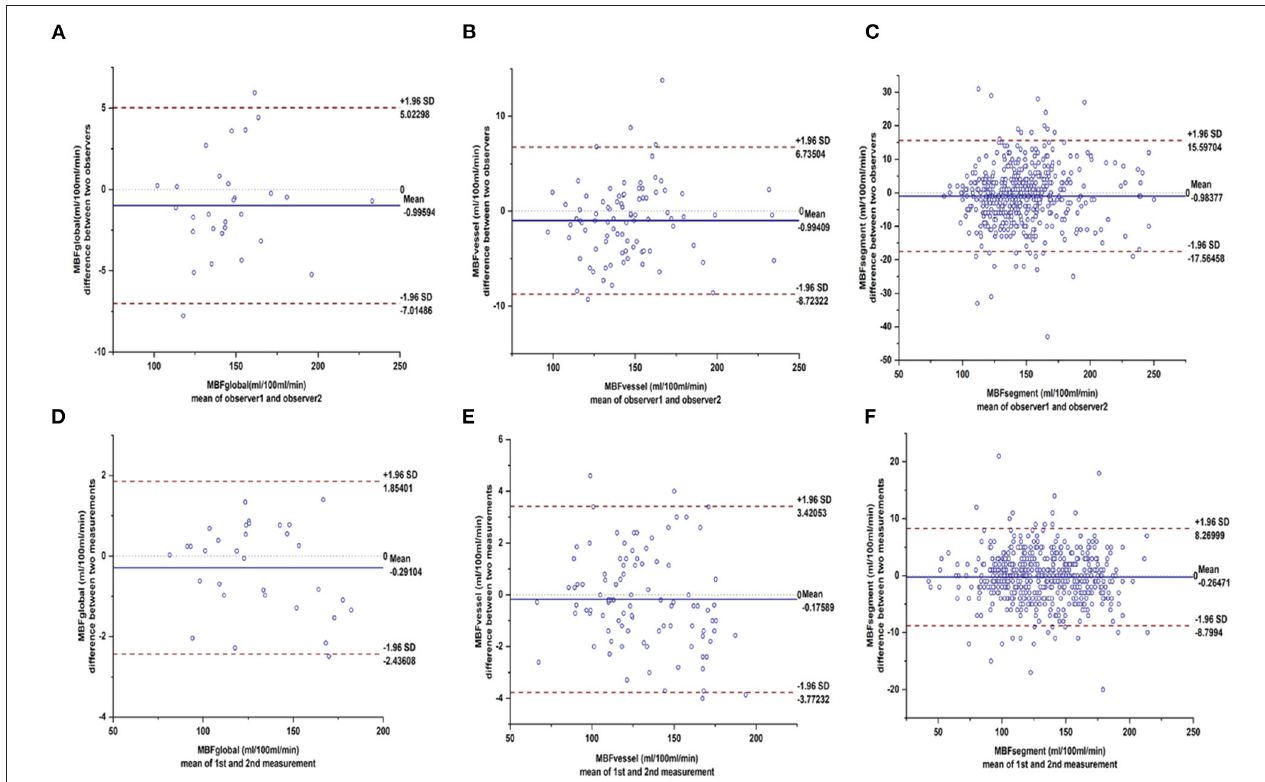
FIGURE 7 | Bland–Altman plots showed excellent inter- and intra-observer agreements of hyperemic MBF. Bland-Altman plots shows the 95% limits of agreement and the mean differences for intra-observer reliability of MBF in (A) segmental level, (B) vessel level, (C) individual level and inter-observer reliability of MBF in (D) segmental level, (E) vessel level, (F) individual level. MBF, myocardial blood flow. people (135 ± 24 ml/100 ml/min vs. 164 ± 24 ml/100 ml/min, ml/100 ml/min vs. 135 ± 24 ml/100 ml/min, p < 0.001).